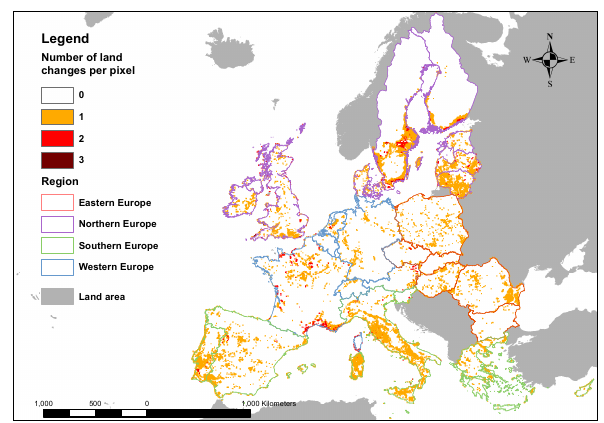
Fig. 5. Generalized prime hotspots of Europe for the period 1950– 2010, showing the spatial distribution of (multiple) land